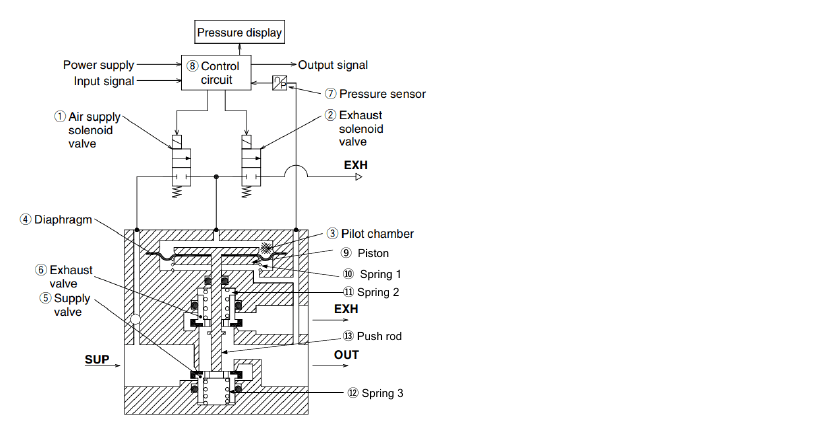
Figure 2. The sketch of the electro-pneumatic proportional valve (Reproduced with permission from [Dawei Hu], [Applied sciences]; published by [MDPI], [2020].)